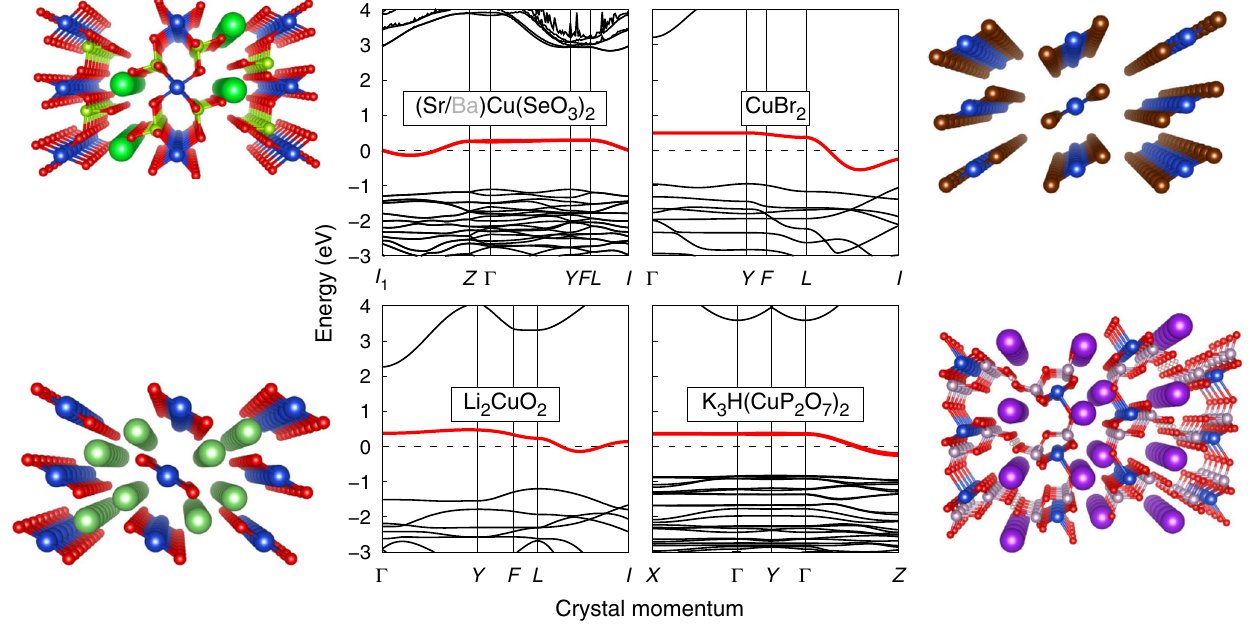
FIG. 3. Crystal structure and DFT electronic band structure of five of the identified one-band correlated materials. The single isolated half-filled electronic bands are shown as the thick red lines. The band structure of BaCu ð SeO 3 Þ 2 is not shown since it appears nearly identical to that of SrCu ð SeO 3 Þ 2